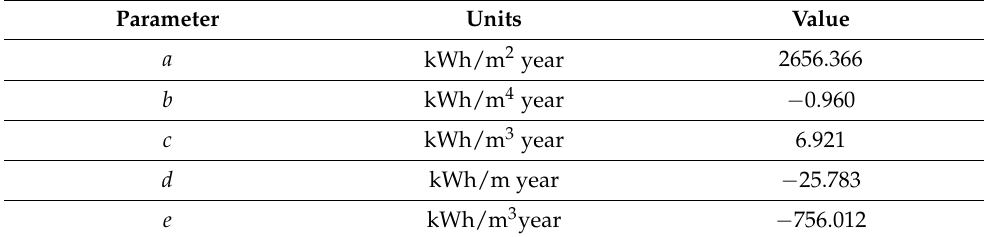
Table 3. Values obtained for the model of Equation